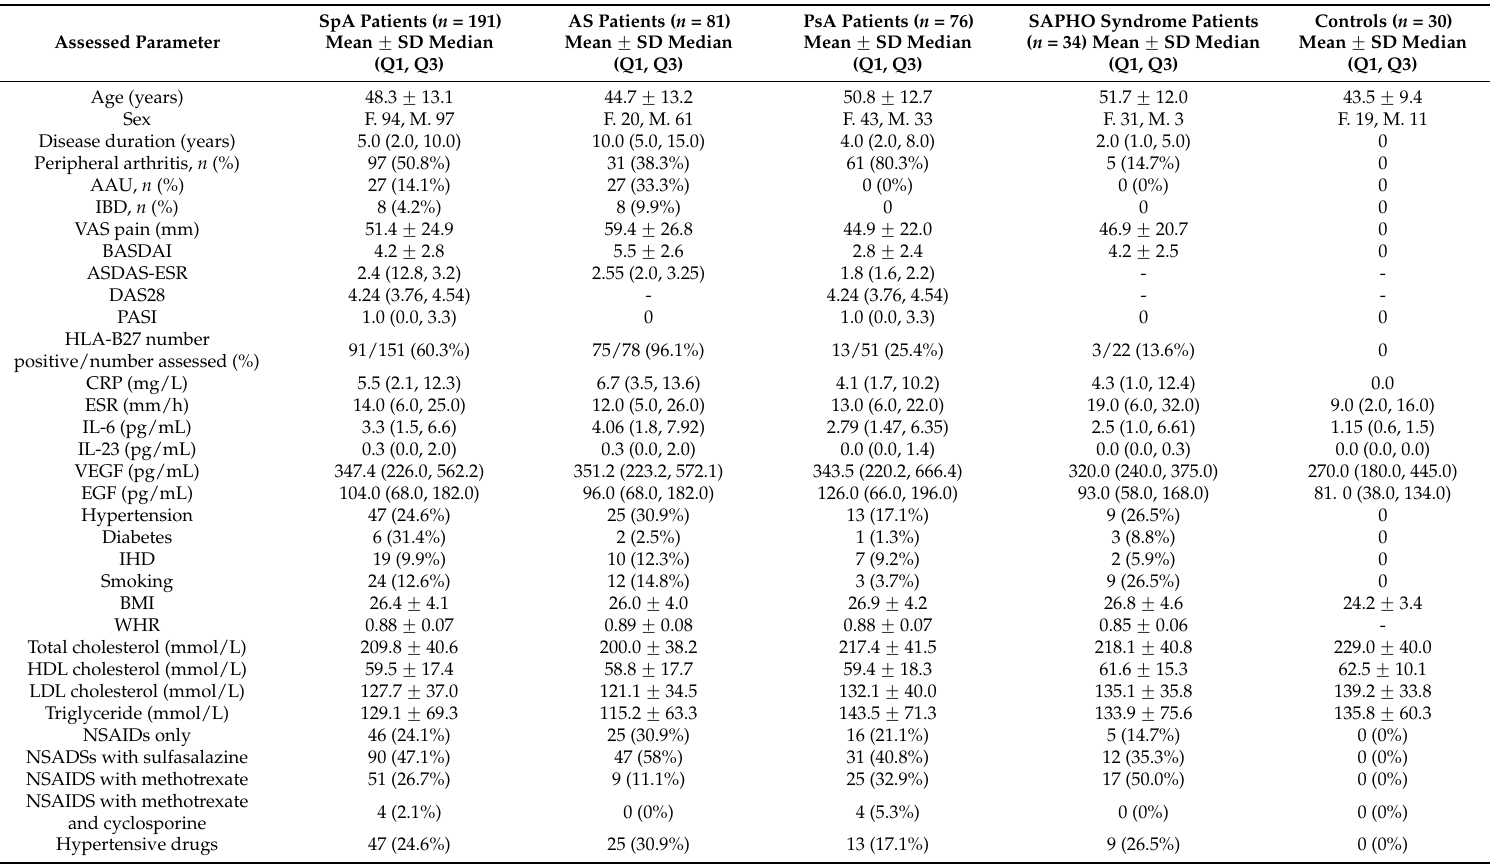
Table 1. Clinical, laboratory characteristics and treatment of the patients and